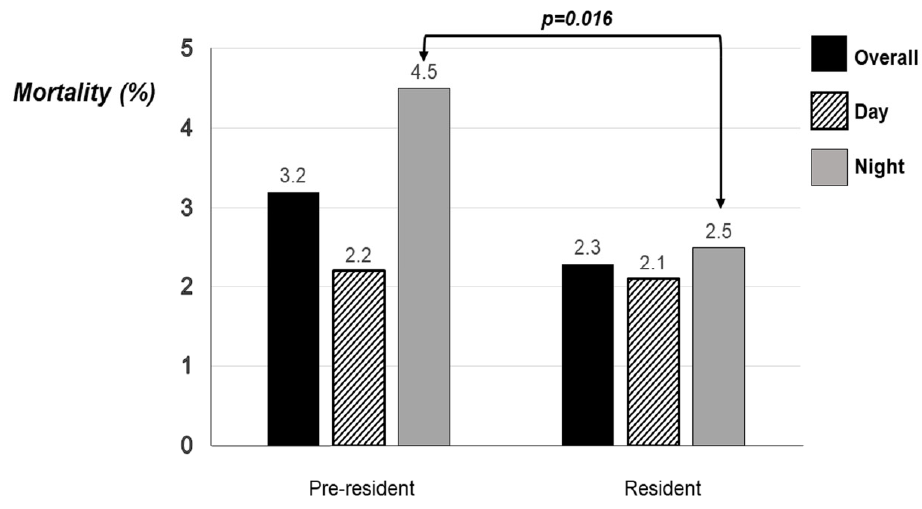
Figure 1. Total, day and night mortality before discharge from neonatal care during the pre-resident and resident periods. Table 2. Comparison of infants that survived versus infants that died before discharge from neonatal care. Median (IQR) or N (%). Comparisons by Mann–Whitney U or x 2 test as appropriate.